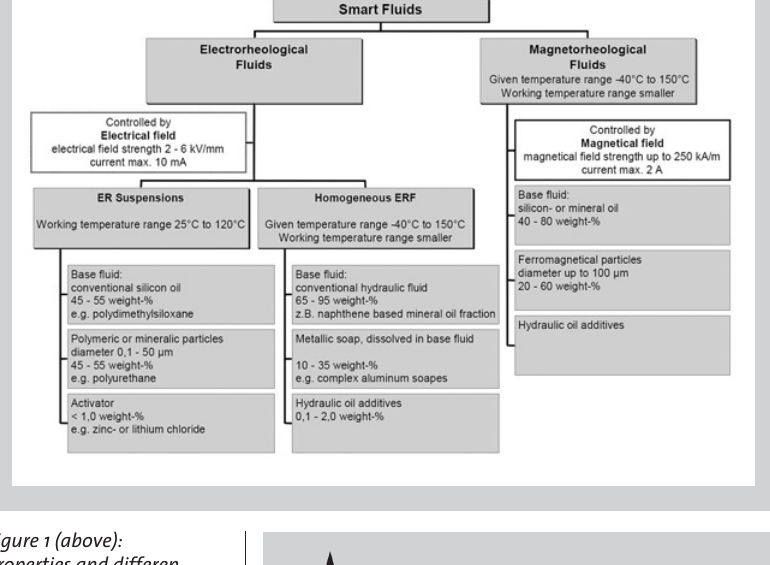
Figure 1 (above): Properties and differen- tiating factors of smart fluids [3]. Figure 2 (middle): Idealized shear behavior of ER suspensions. Figure 3 (below): Catenation of the particles in an ERF exposed to the electric